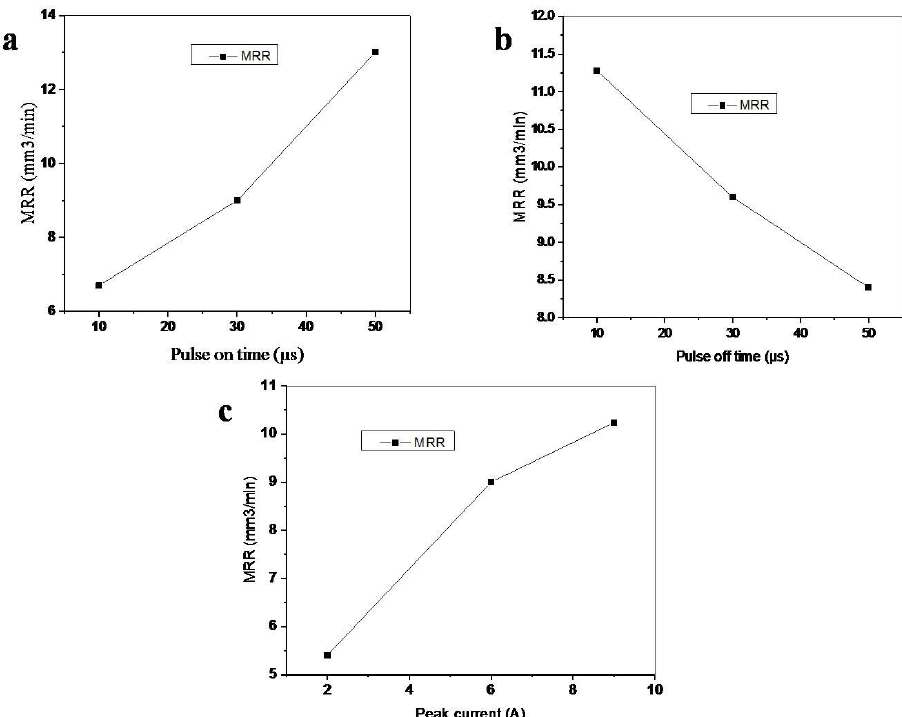
Figure 3: Main effect Plots for MRR (a) Ton Vs MRR; (b) Toff Vs MRR; (c) Ip Vs MRR